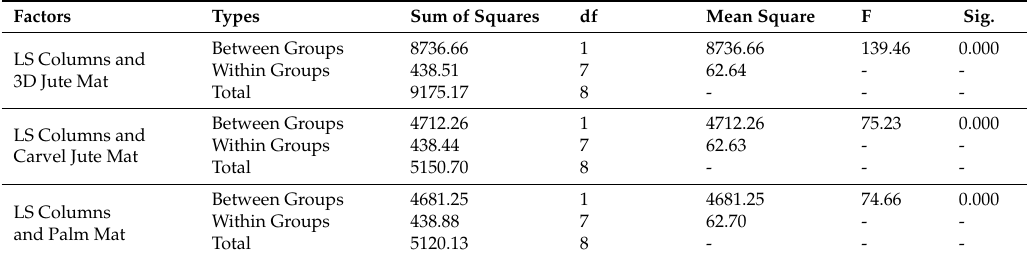
Table 5. Analysis of Variance (ANOVA) of water desorption of LS